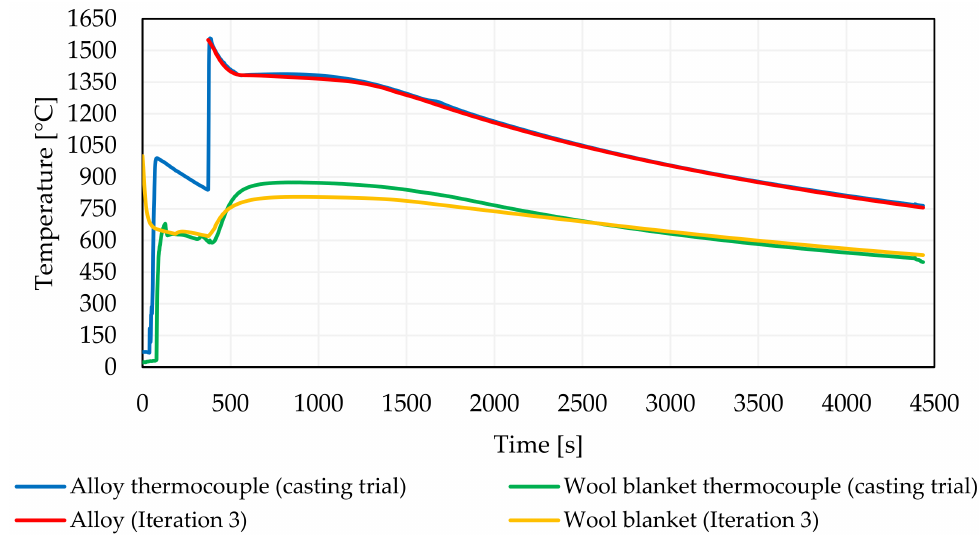
Figure 18. Temperature evolution in the casted part and in the insulation wrap, obtained from experimental trial and simulation.